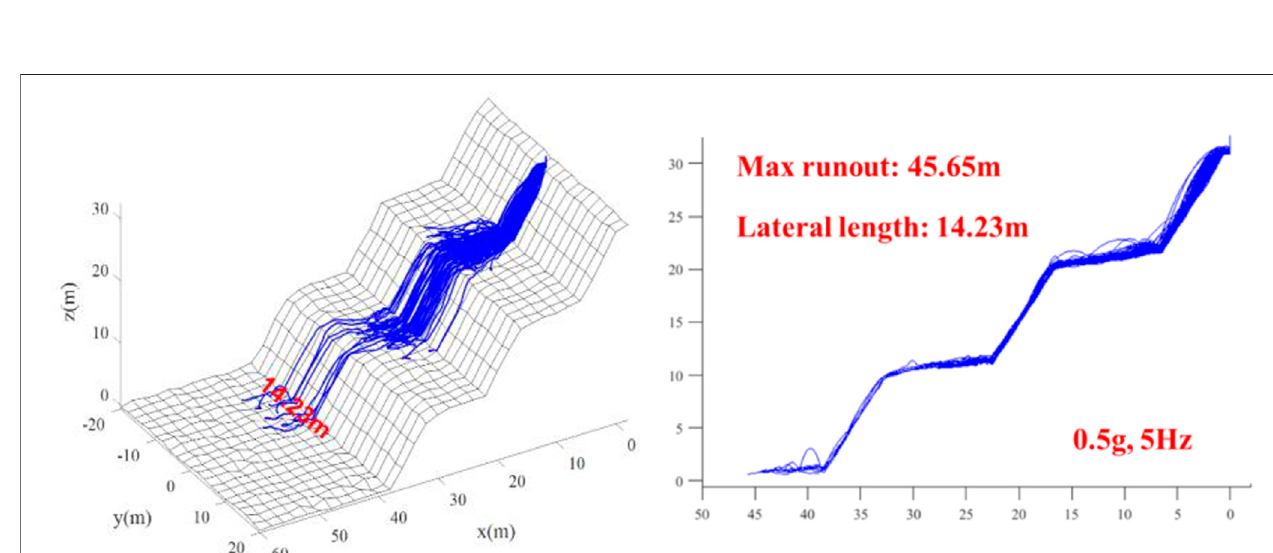
FIGURE 9 | Rockfall trajectories without seismic load (C1).